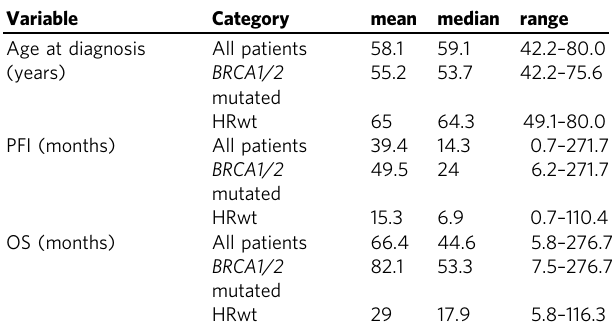
Table 1 Summary of patient clinical